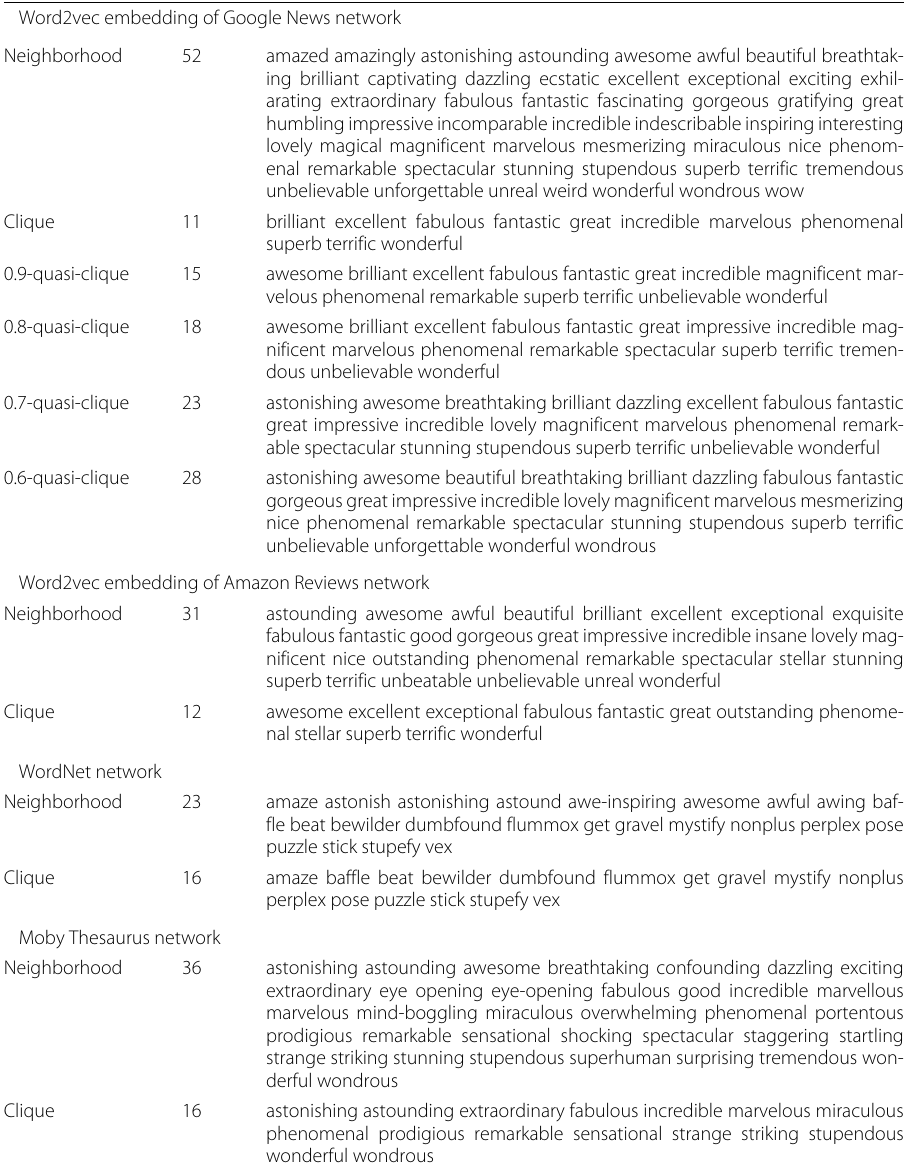
Table 8 Neighborhood of the word ‘amazing’, largest clique and quasi-cliques in its neighborhood in word2vec embedding of Google News network with 0.5 similarity cutoff Cluster type Size